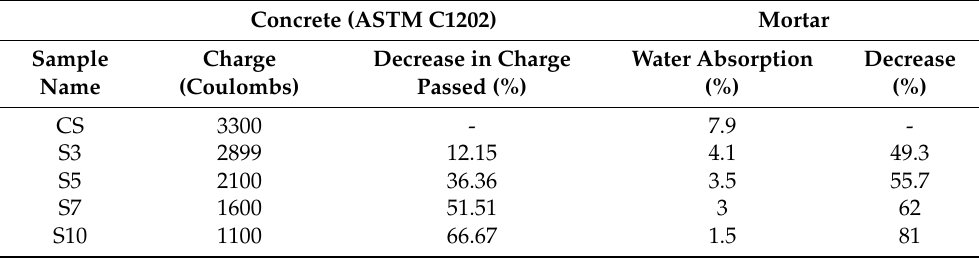
Table 8. Permeability of concrete and